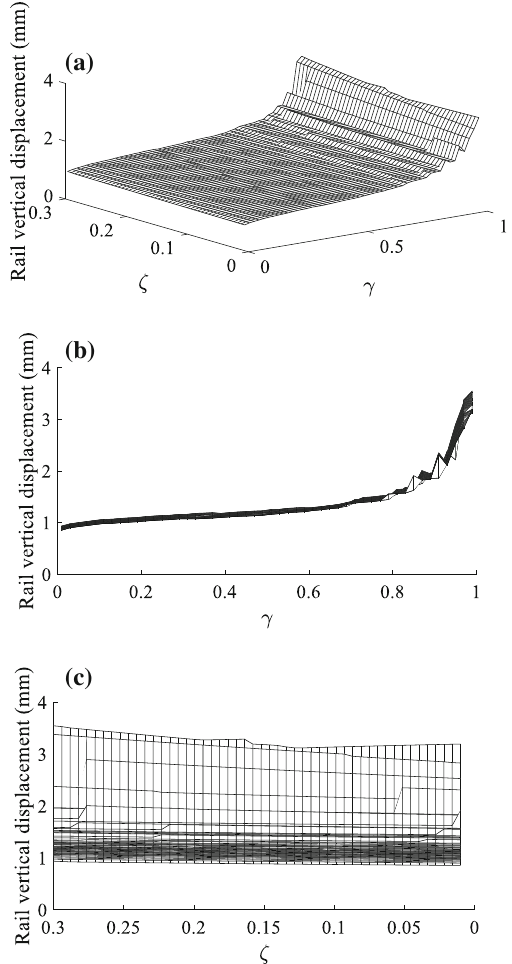
Fig. 18 Rail vertical displacement against the changes of track irregularity probability level c and parameter COV f ( a 3D view; b side view; c end